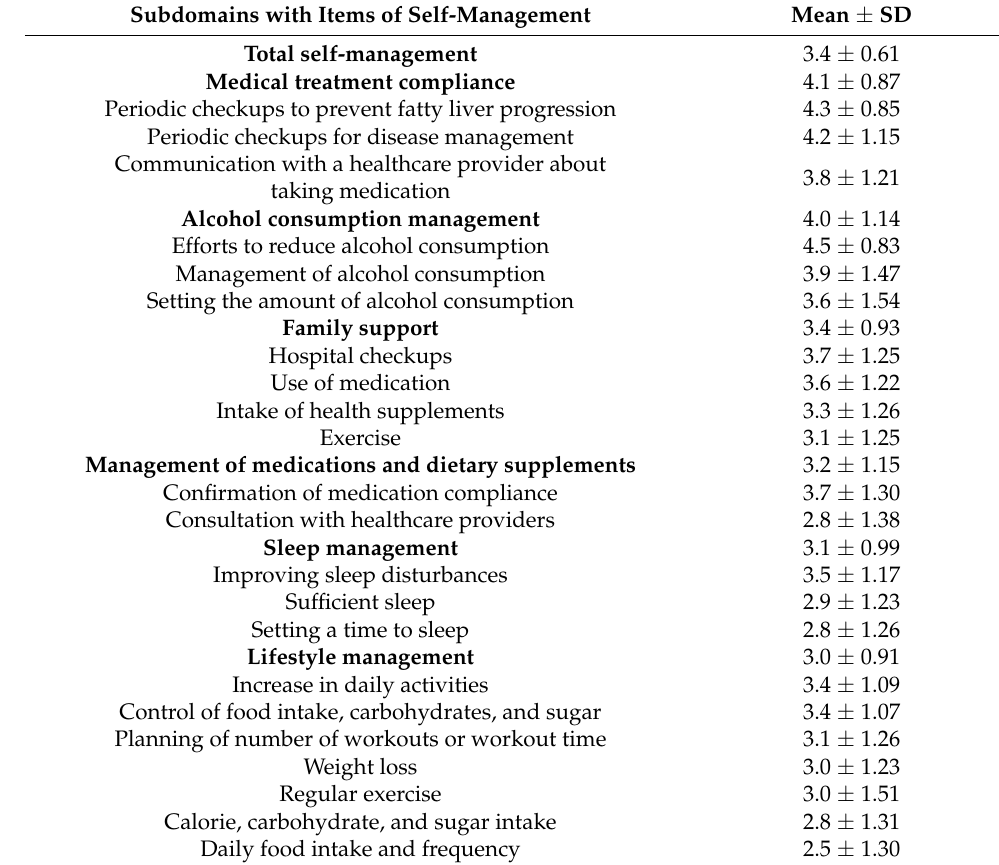
Table 2. The level of self-management among participants with NAFLD ( N =